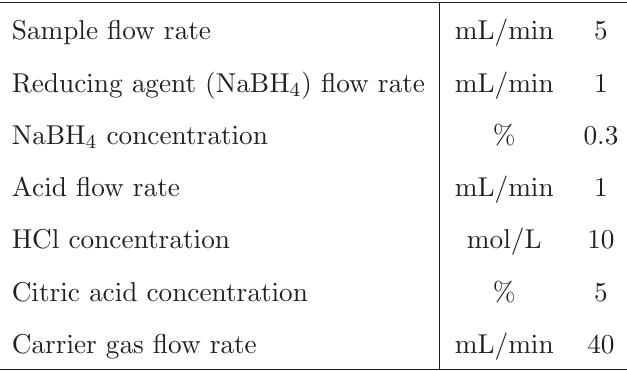
Table 1 Parameters of the analytical system used for hydride